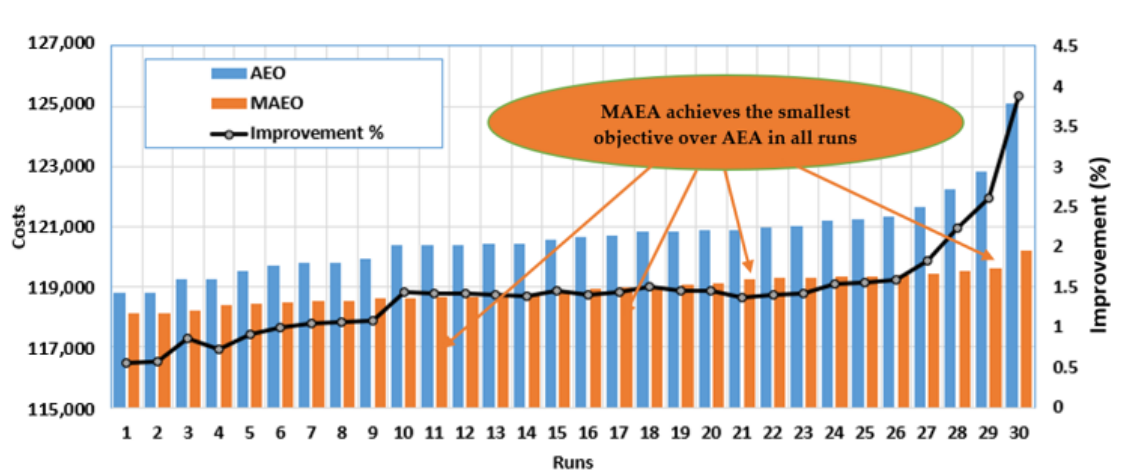
Table 10. Robustness metrics of the proposed MAEA and the basic AEA of Case 4. Costs (USD/h)